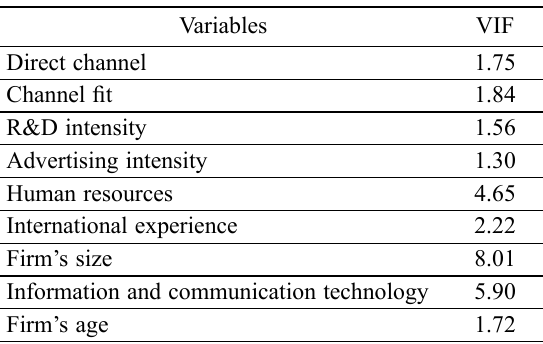
Table 5. Variance inflation factors